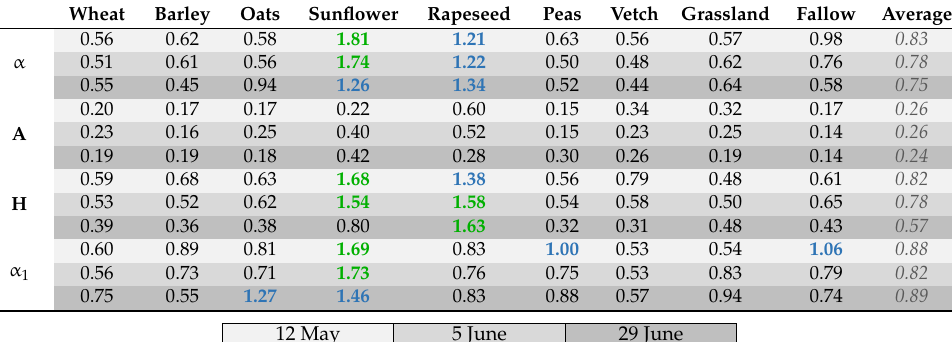
Table 4. Average JM distance for each studied crop and date as well as the average of all crop pairs, for the Cloude–Pottier features H-A- α and α 1 . Colors and shades as in Table